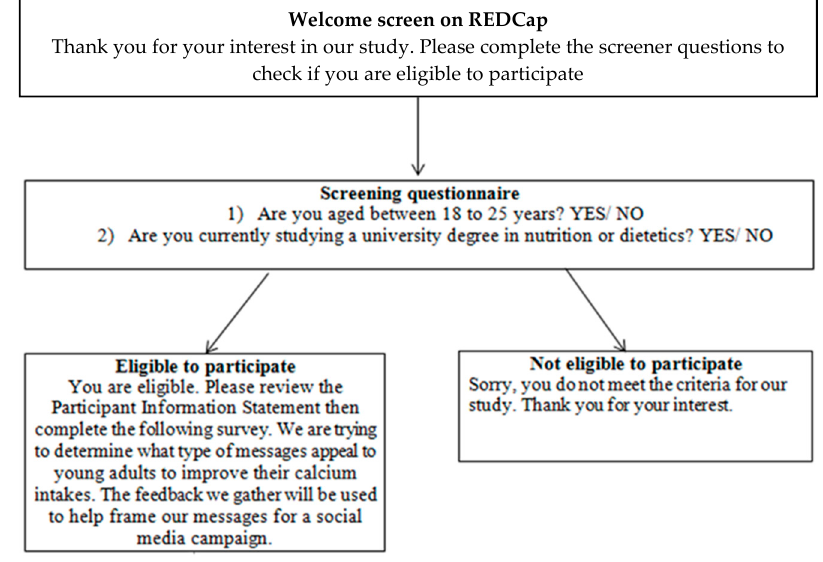
Figure 1 . Survey recruitment process. Figure 1. Survey recruitment